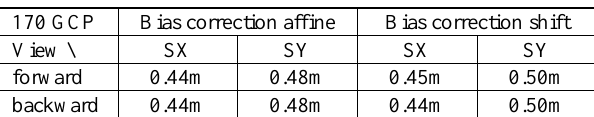
Table 2. 3D-determination of ground control points